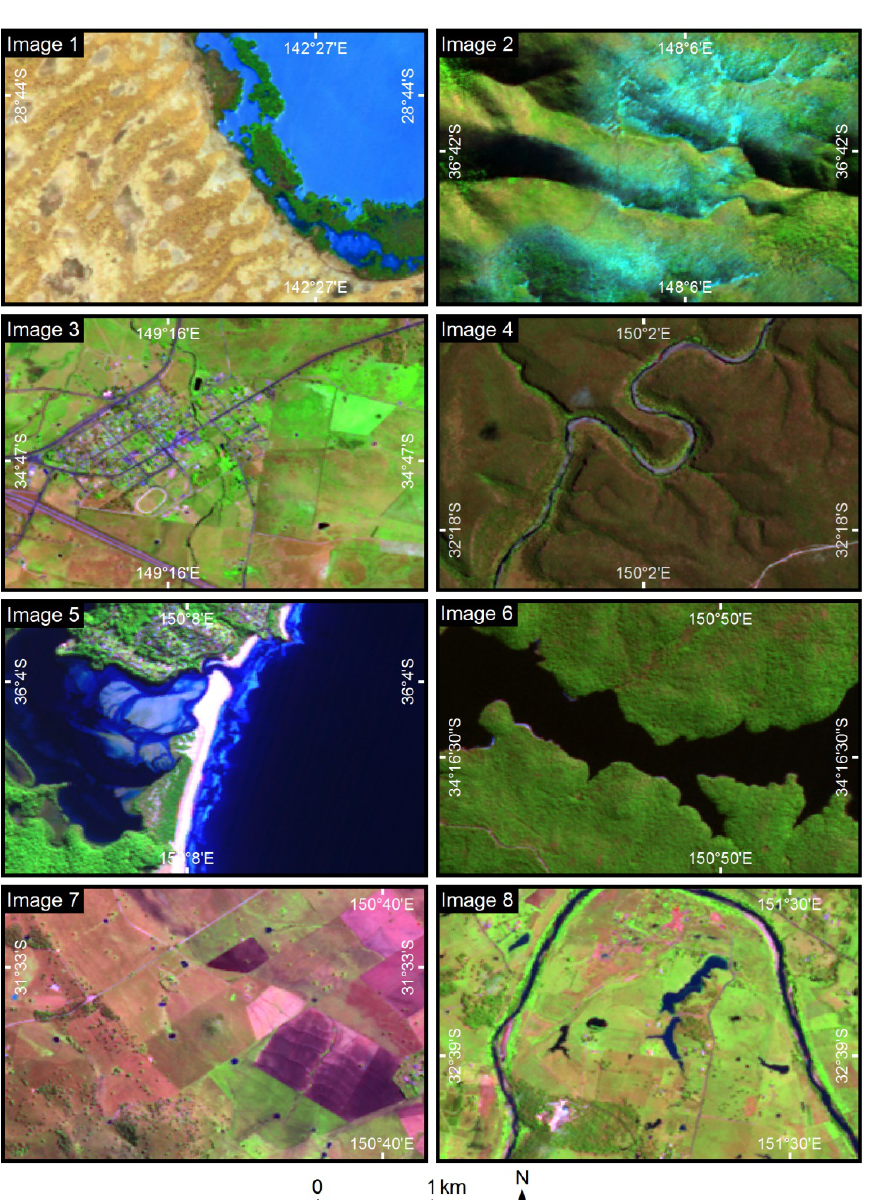
Figure 3. Subsets of the training images numbered in Figure 2, showing the variety of water present across New South Wales, Australia. Images are shown with bands 4, 3 and 1 as red, green and blue. Water is present as ephemeral playa lakes (Image 1), snow covered forest (Image 2), small dams close to urban areas (Image 3), rivers within forests (Image 4), coastal estuaries and beaches (Image 5), large dams (Image 6), small dams (Image 7) and rivers within farmland (Image